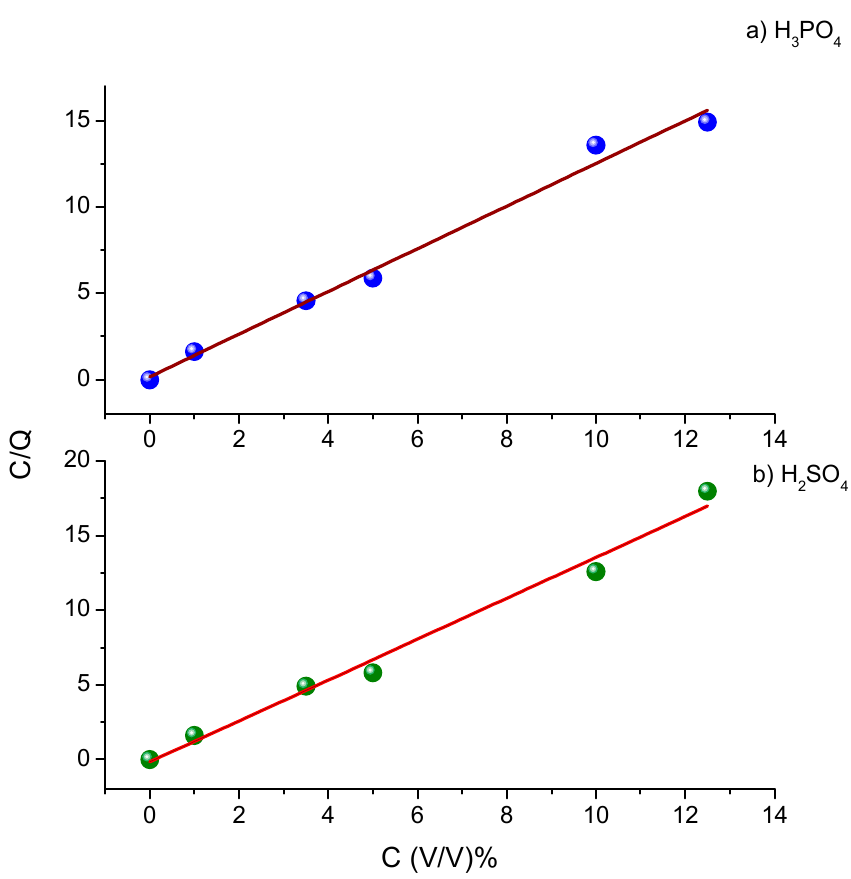
Figure 7 . Langmuir adsorption isotherm for ( a ) H3PO4 and ( b ) H2SO4 with different concentration of ASMS. of